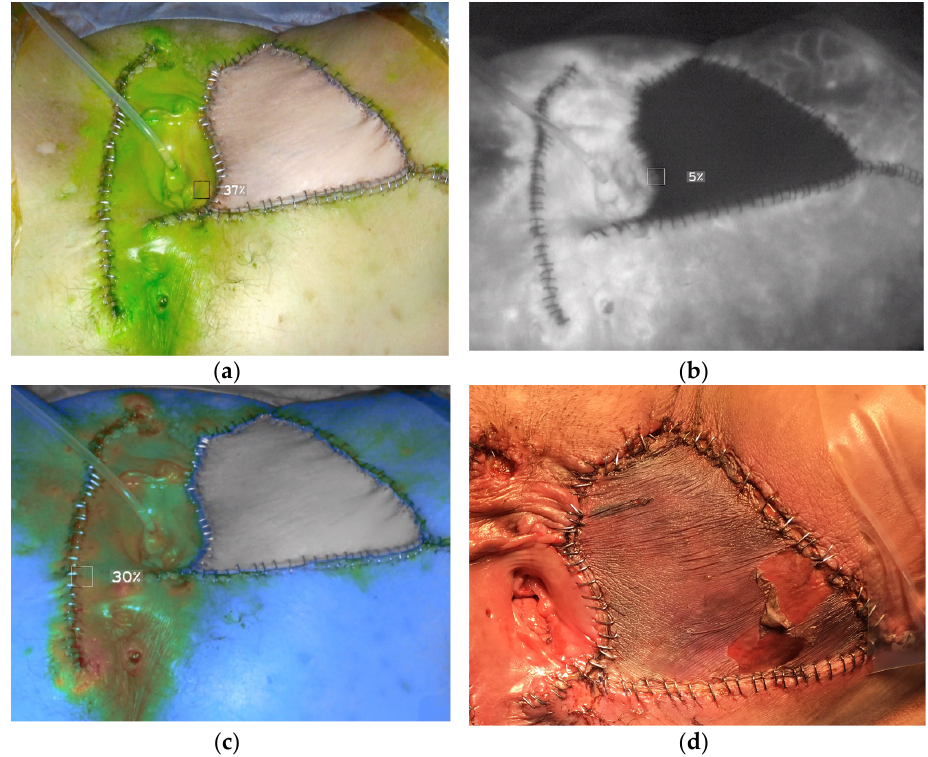
Figure 2. Perfusion assessment with fluorescence imaging system after injecting indocyanine green in ( a ) Overlay mode; ( b ) SPY fluorescence mode; ( c ) Color segmented fluorescence mode and ( d ) White light one week after surgery. This figure showed the very poor flap perfusion indicated with ICG-imaging study intraoperatively and the necrotic flap one week later.